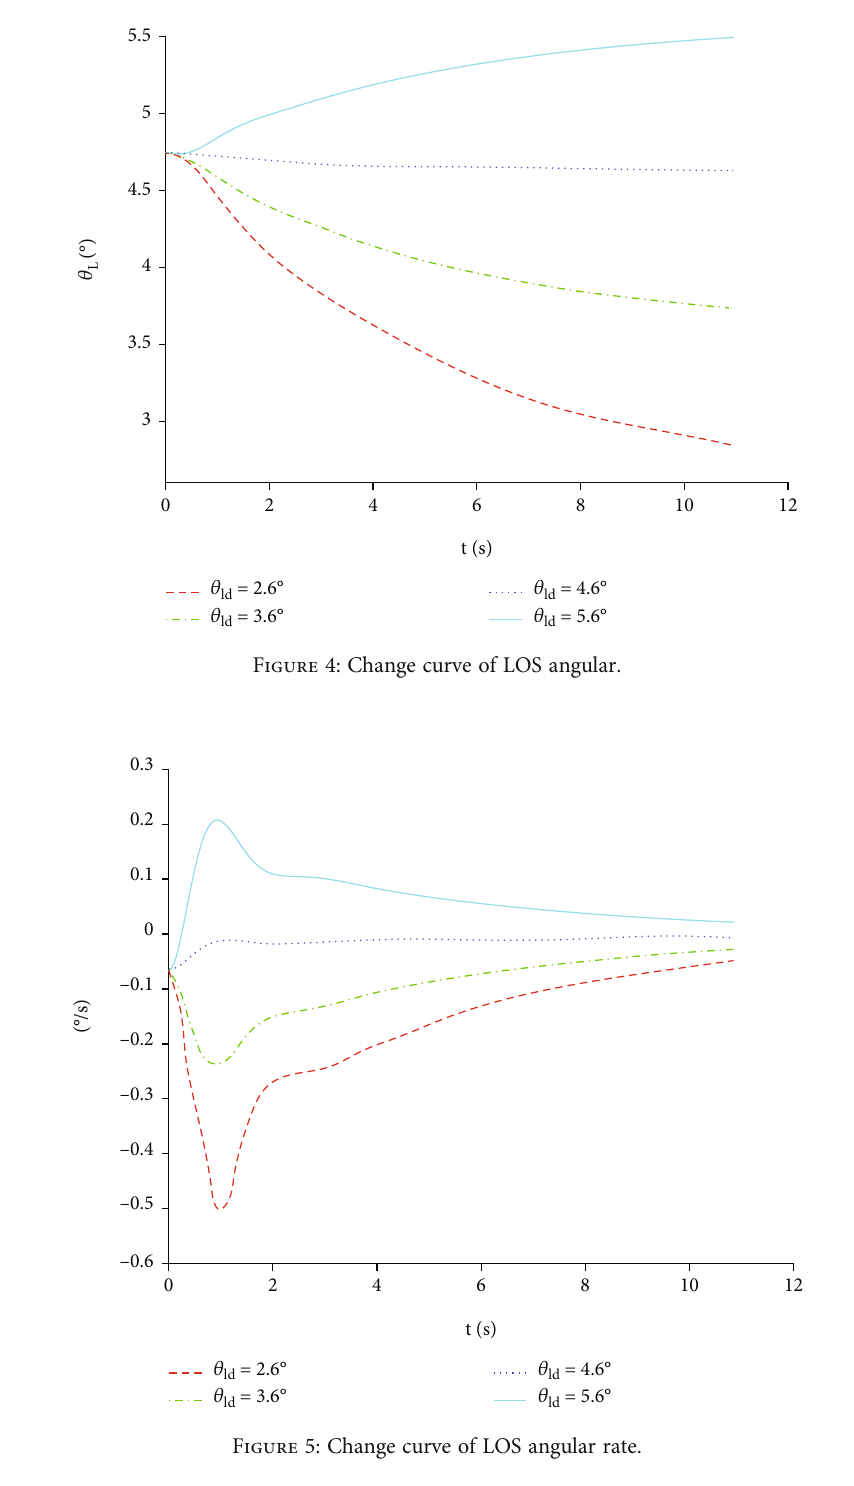
Figure 5: Change curve of LOS angular